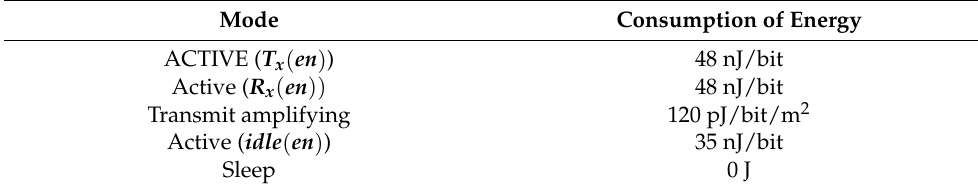
Table 3. Energy consumption in sleep scheduling. Mode Consumption of